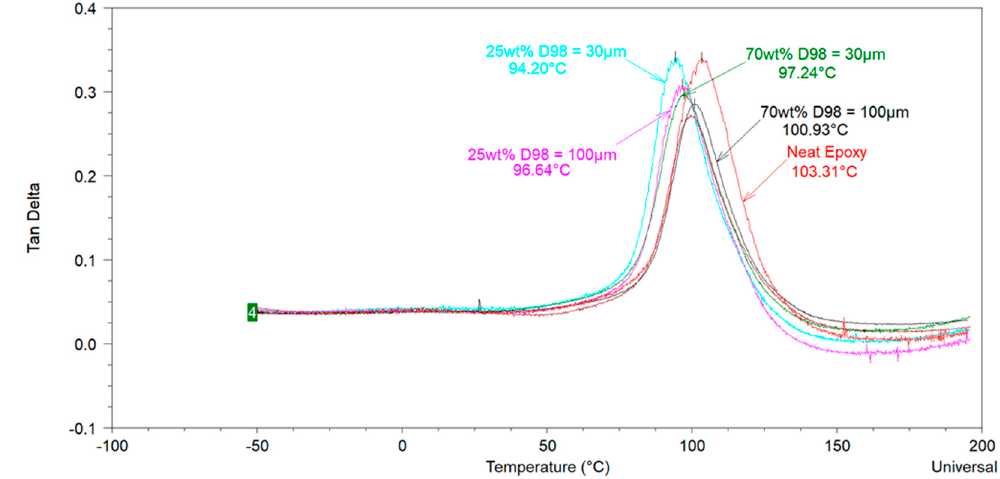
Figure 6. Tan Delta curves of epoxy coatings with di ff erent sized feldspars obtained from DMA.